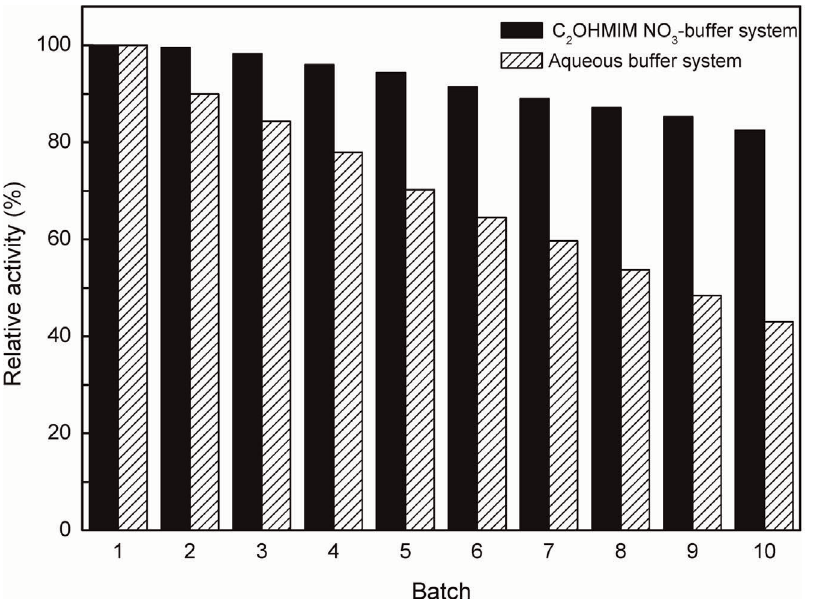
Figure 6. Operational stability of immobilized Candidaparapsilosis cells. Reaction conditions with C 2 OHMIM ? NO 3 -buffer system: 3.0 mmol/L TMSB, 4.0 mL TEA-HCl buffer (100 mmol/L, pH 5.0) containing 10% (v/v) C 2 OHMIM ? NO 3 , 98.1 mmol/L 2-propanol, and 0.15 g/mL immobilized C. parapsilosis cells, 30 u C, 180 r/min, 1 h per batch; Reaction conditions with aqueous buffer system: 3 mmol/L TMSB, 4.0 mL of TEA-HCl buffer (100 mmol/L, pH 5.0), 65.3 mmol/L 2-propanol, 0.15 g/mL immobilized C. parapsilosis cells, 30 u C, 180 r/min, 1 h per batch. The relative activity of the immobilized cells in the first batch was defined as 100%.